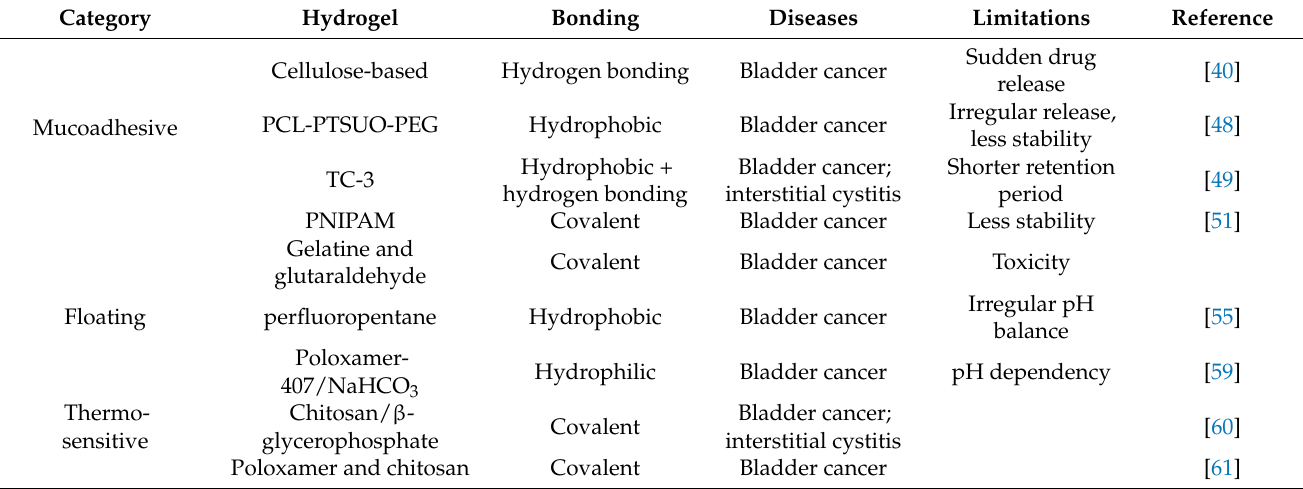
Table 1. Various type of hydrogels in